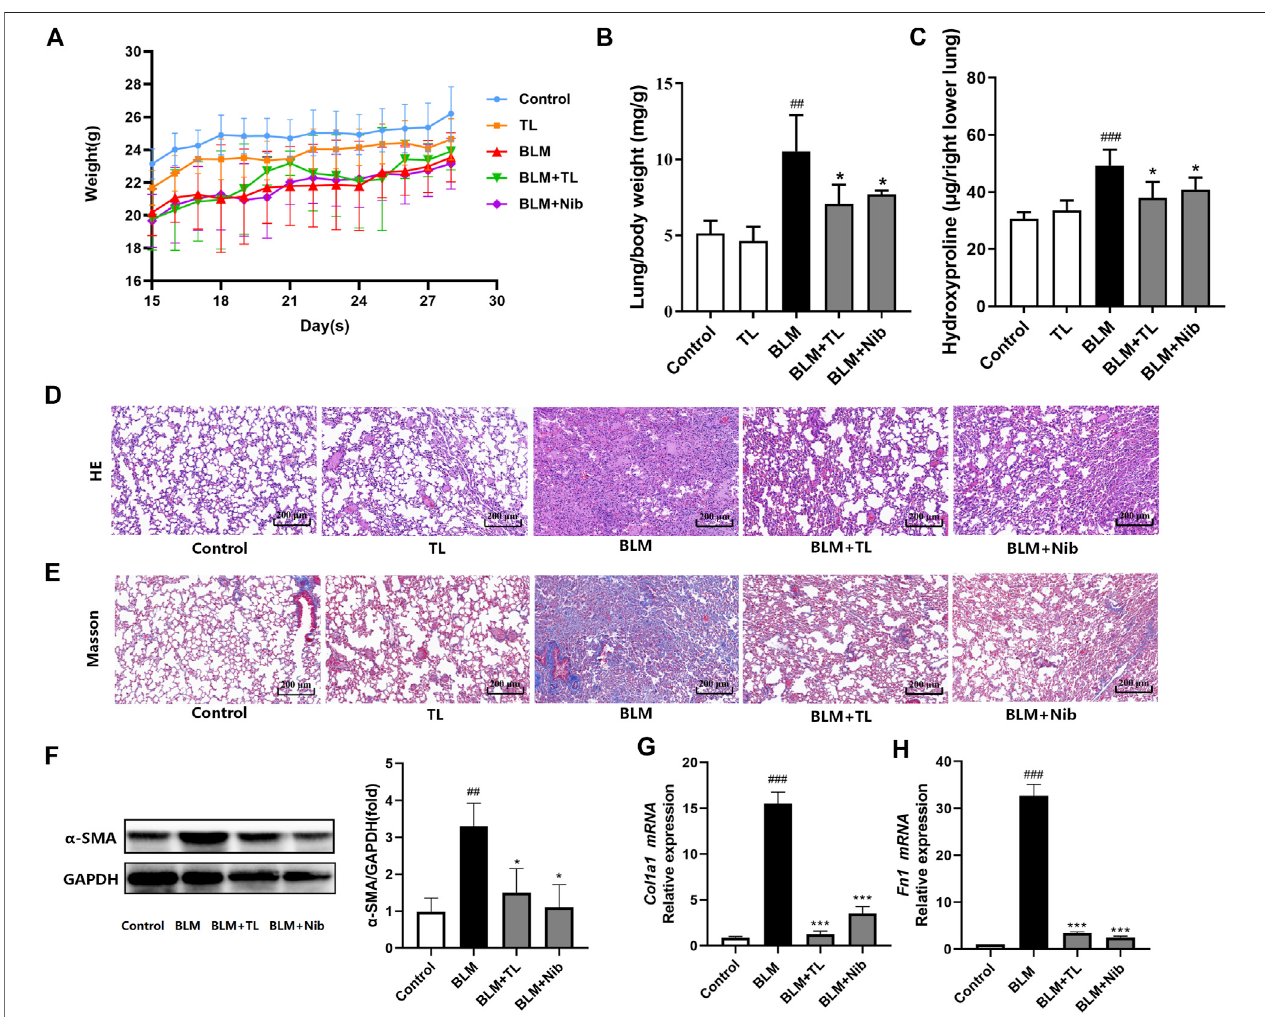
FIGURE 2 | TL-treated mice are protected against BLM-induced pulmonary fi brosis. After 14 days of BLM (2.5 mg/kg) or 0.9% saline treatment, mice were orally administratedwithTL(45 mg/kg),Nib(nintedanib,60 mg/kg,positivedrug)or0.9%salineonceadayfor14 days (A) changesofbodyweightofmice( n (cid:2) 5 – 10) (B) lung coef fi cient ( n (cid:2) 5) (C) quanti fi cation of hydroxyproline contents ( n (cid:2) 5) (D-E) H and E and Masson ’ s trichrome staining section of lung tissue ( n (cid:2) 3) (F) the expression of α -SMA in lung tissue were detected by western blot and densitometrically quanti fi ed data of α -SMA/GAPDH expression ratio ( n (cid:2) 3) (G-H) relative mRNA expression of Col1a1 and Fn1 were detected using real time-PCR analysis ( n (cid:2) 3). Data were expressed as mean ± SEM, vs. the Control group, # p < 0.05, ## p < 0.01, #### p < 0.001, vs. the BLM group *p < 0.05, **p < 0.01, ***p < 0.001.